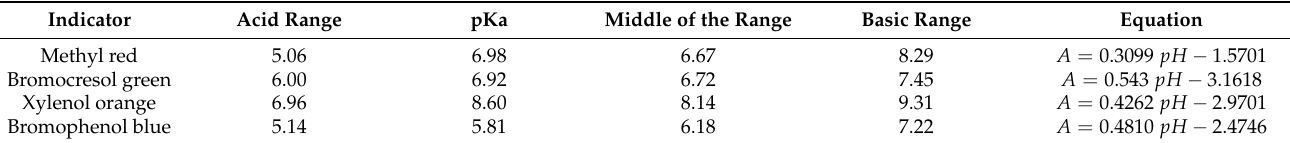
Table 5. Values of the turning range and pKa found for the ethanolic medium 93% (m/m).